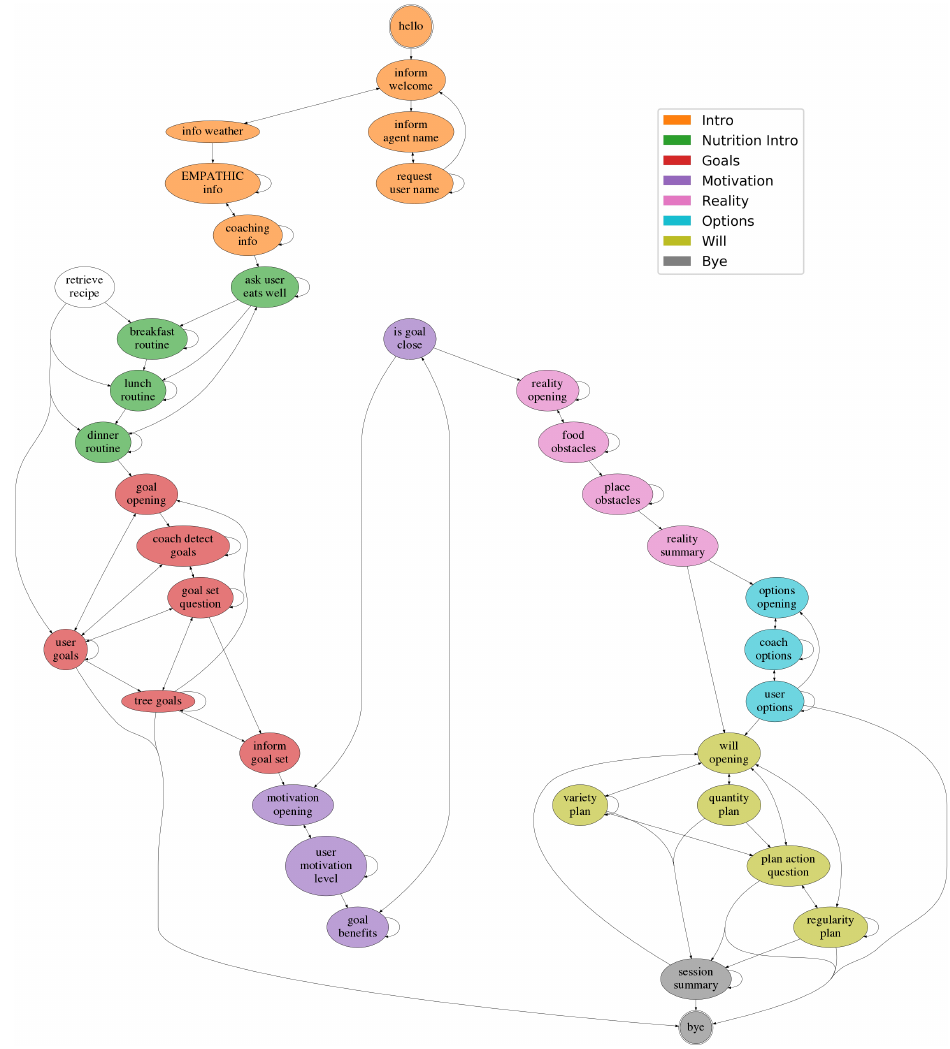
Figure 12. Dialogue flow graph obtained from the interactions between users and the final prototype of the VC. The nodes are groups of system turns and the arrows indicate common transitions. The colours indicate the dialogue phase the grouped turns belong